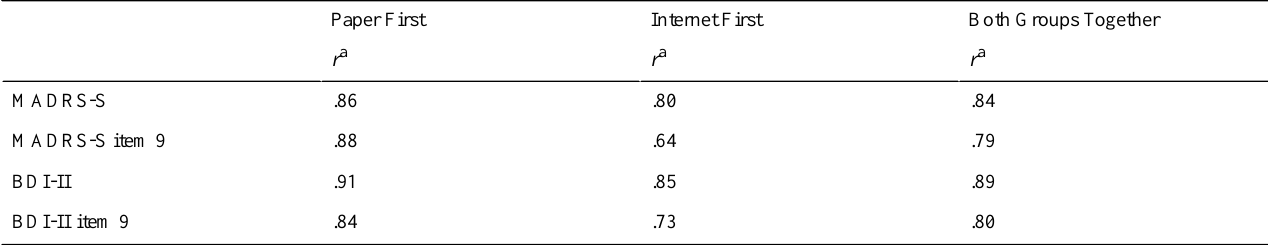
Table 2. Pearson Correlations between scores from paper and the Internet